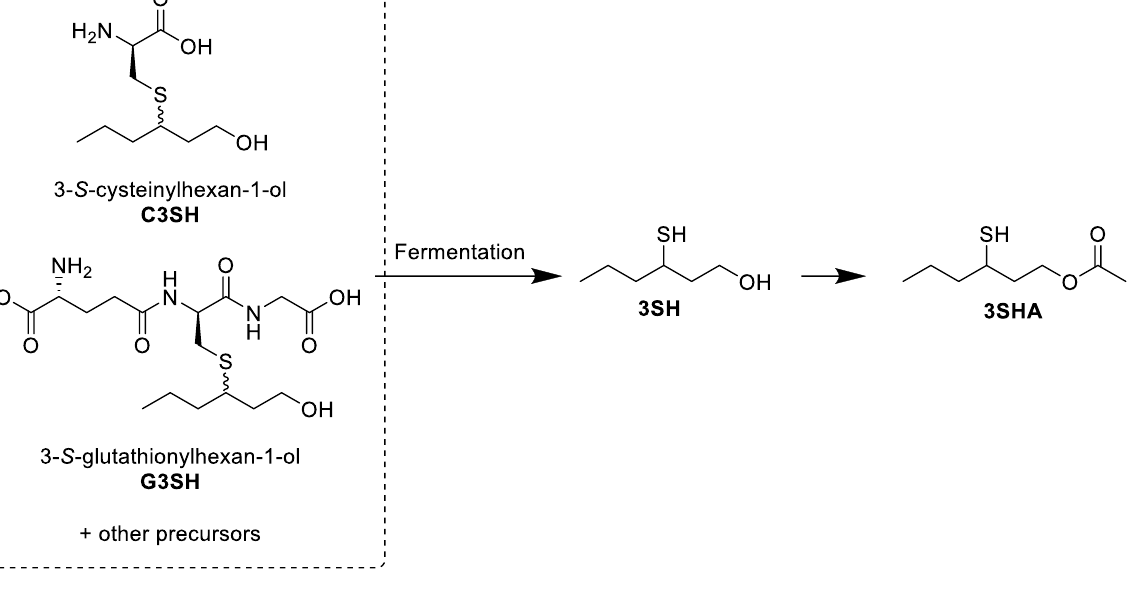
Figure 2. 3SH is released from non-volatile precursors, including 3-S-cysteinylhexan-1-ol (C3SH) and 3-S-glutathionylhexan-1-ol (G3SH), during fermentation, and 3SH can then be acetylated via yeast to